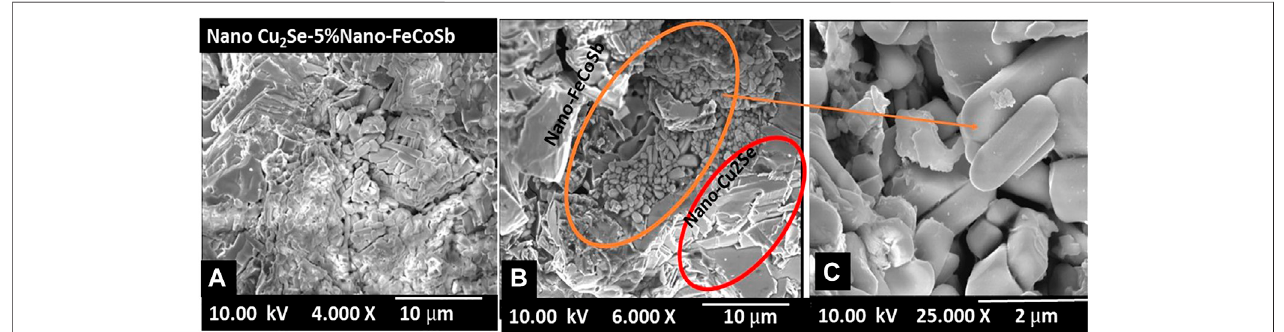
FIGURE 4 | Fractural SEM micrographs of (nano-Cu